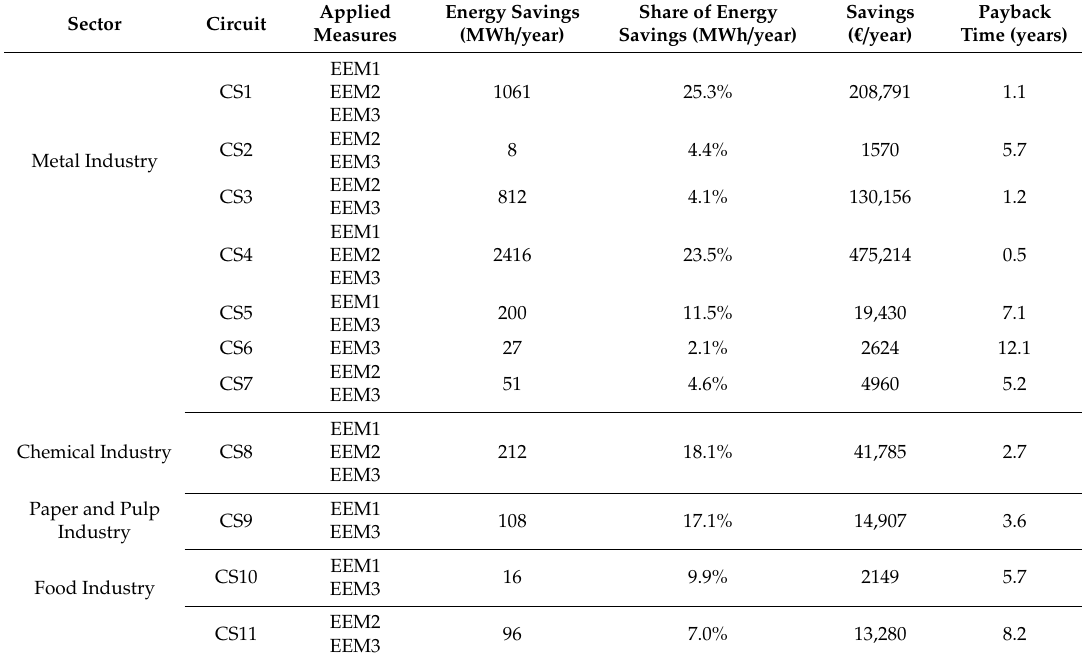
Table 7. Energy and economic savings and payback time for the application of aggregated